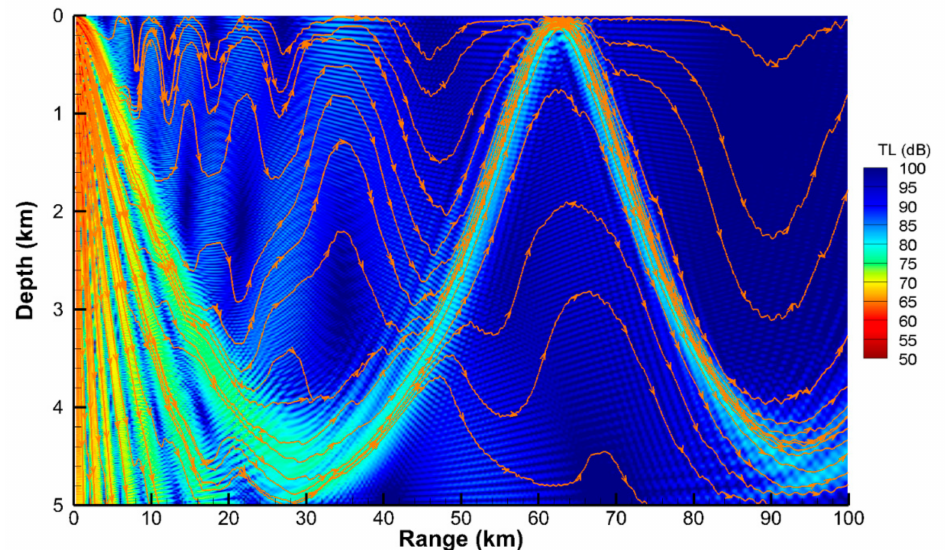
Figure 11. TL contours and TASI streamlines obtained from the VWI model using the 4th-order FDM.